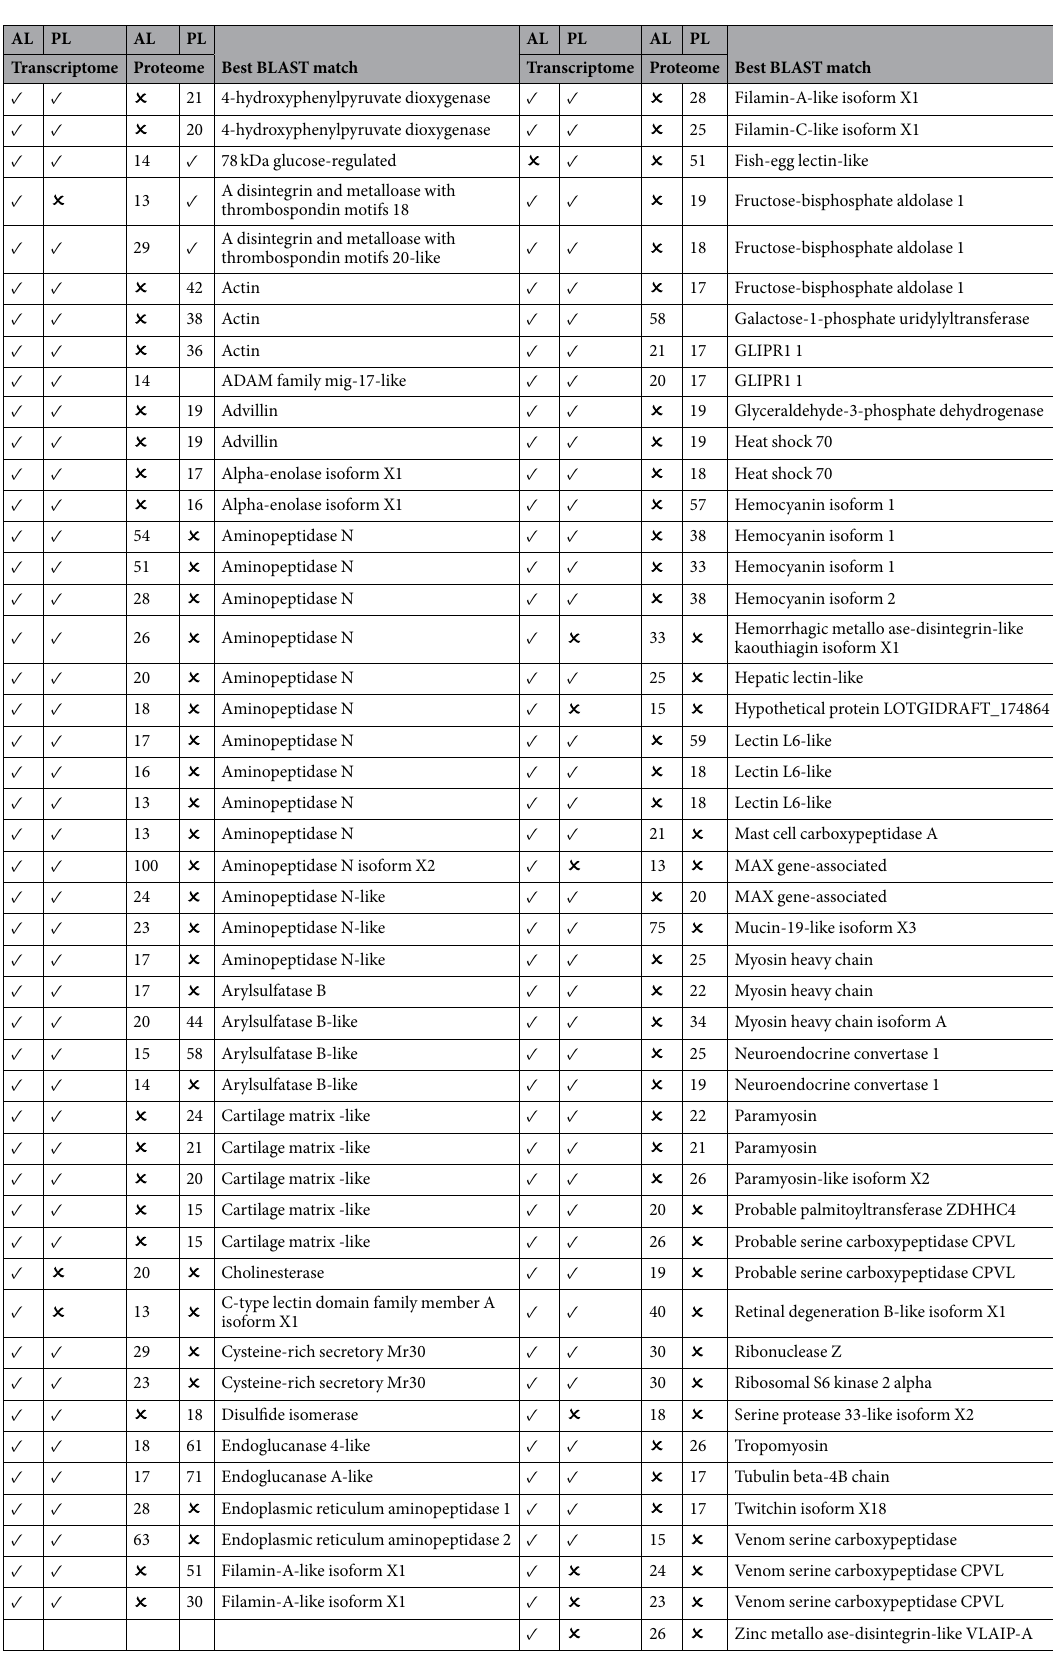
Table 1. Proteins identified in the anterior lobe (AL) and posterior lobe (PL) of the Charonia tritonis salivary gland (SG). (✓) Represents identified, and ( ) represents not identified. Numbers represent number of peptide sequences from the proteomic analyses that match to the